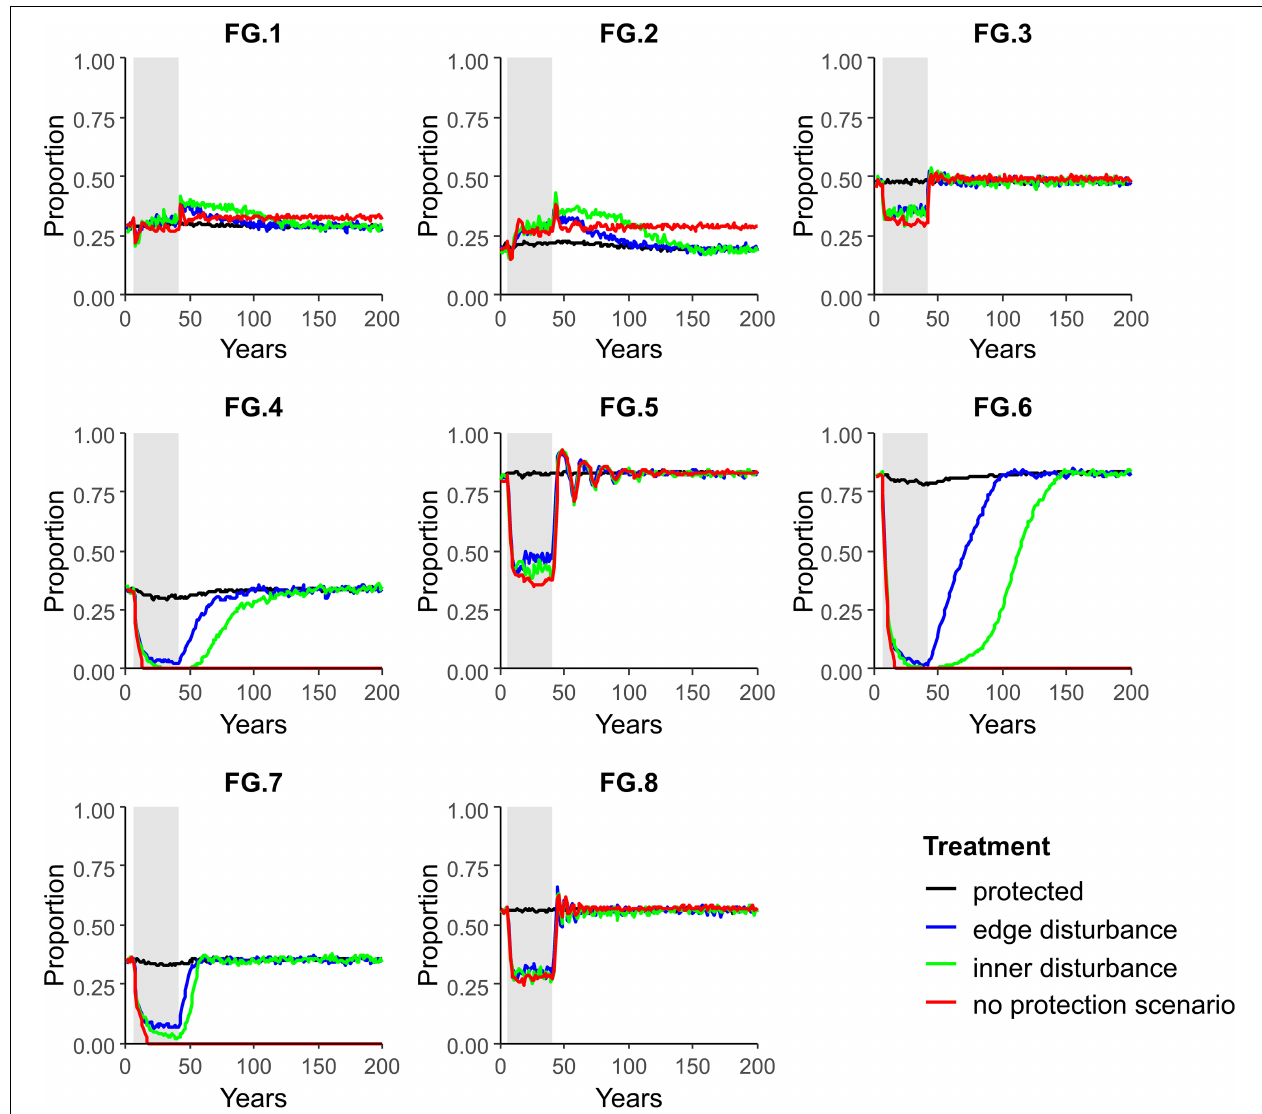
FIGURE 4 | Proportion of seascape occupied by adults of each FG over time in four regions within the model seascape (“inner disturbed” and “edge disturbed” where disturbances were simulated; “protected” where no disturbances were simulated; and “no protection” which was a separate model, with the same dimensions as the impact area but included no protected areas). Scenario were parameterized with a 20% disturbance per year for 35 years within an impact area of 25% of the total model area (75% of the area in benthic protected area).